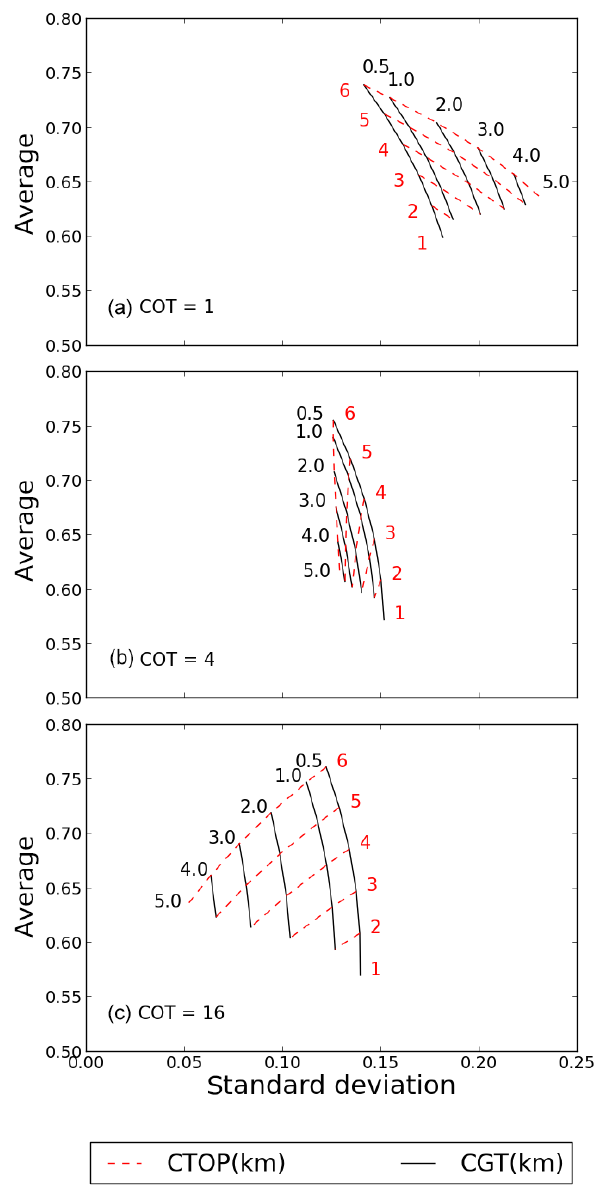
Figure 6. Look-up tables for different cloud top height CTOP and cloud optical thickness CGT, simultaneously of average and angular standard deviation of the 3MI’s A-band ratio. In red, CTOP values and in black, CGT values: (a) COT = 1, (b) COT = 4, (c) COT =